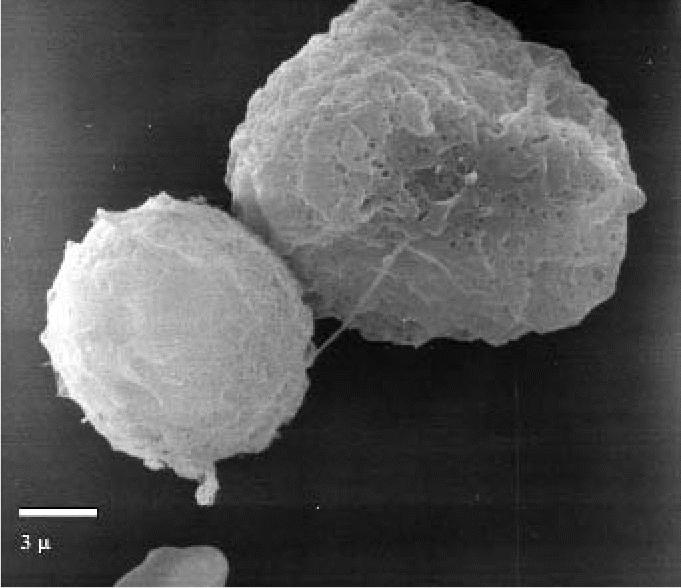
Scanning electron micrograph showing the “smooth” surface pattern of large macrophages (exposed subject). Bar = 3 μm.